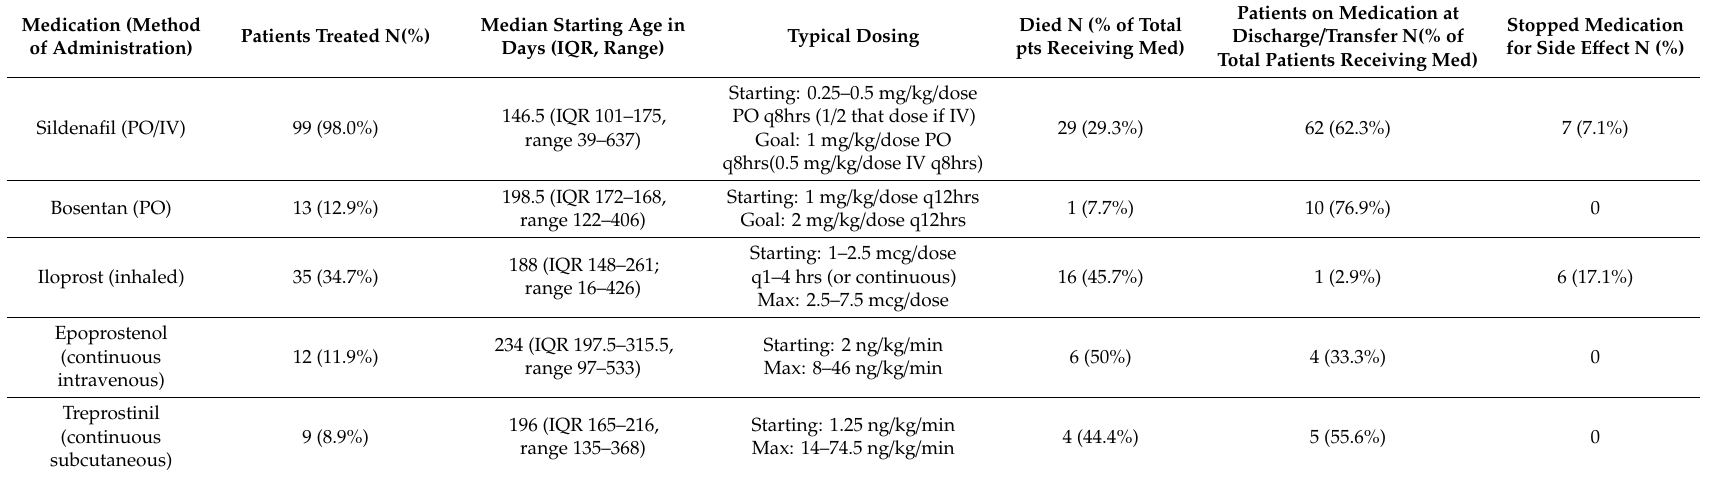
Table 4. Pharmacologic